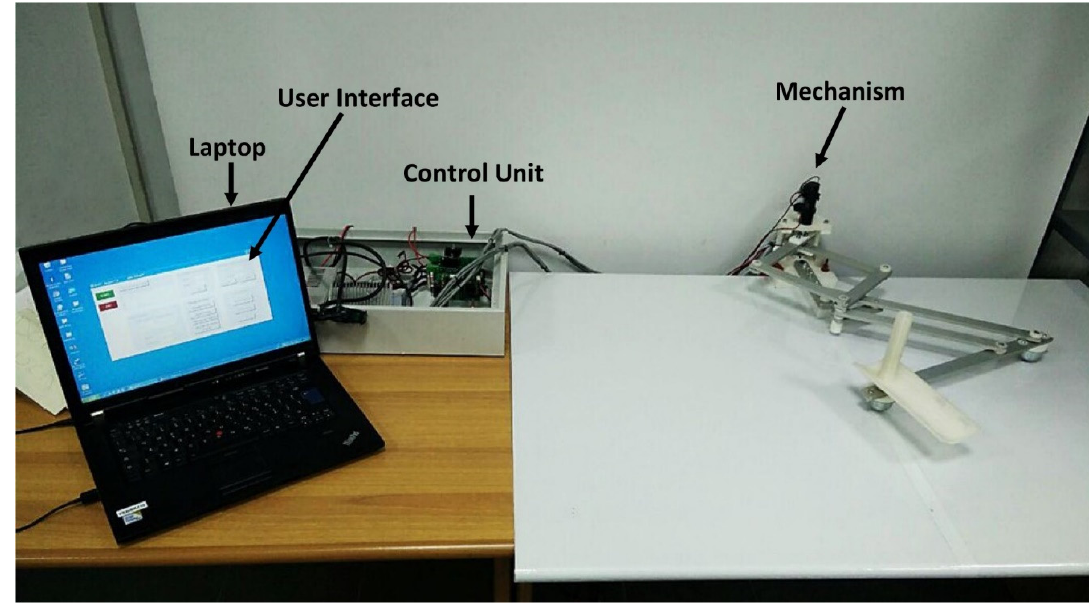
Figure 10. The built control unit as connected to the designed mechanism.